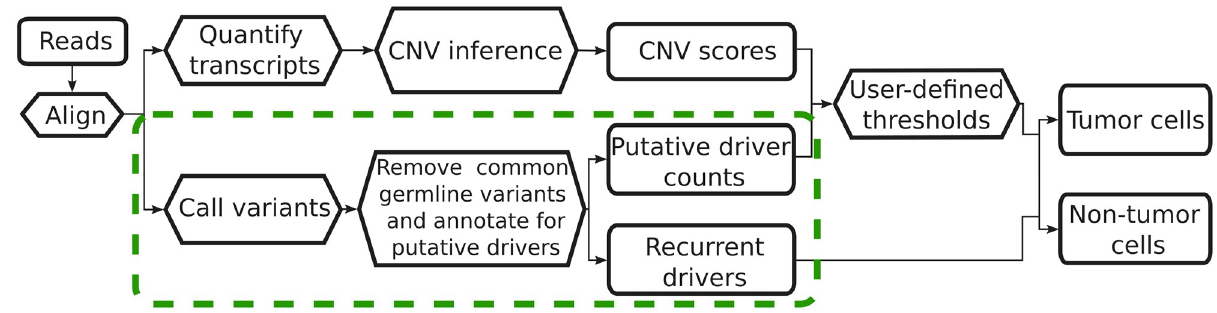
Fig 4. Flowchart depicting a cancer-cell-filtering process. Additional steps proposed in this work, to include variant calling and analysis, are shown by the green dashed rectangle. Solid rectangles indicate inputs and outputs, hexagons indicate processes.